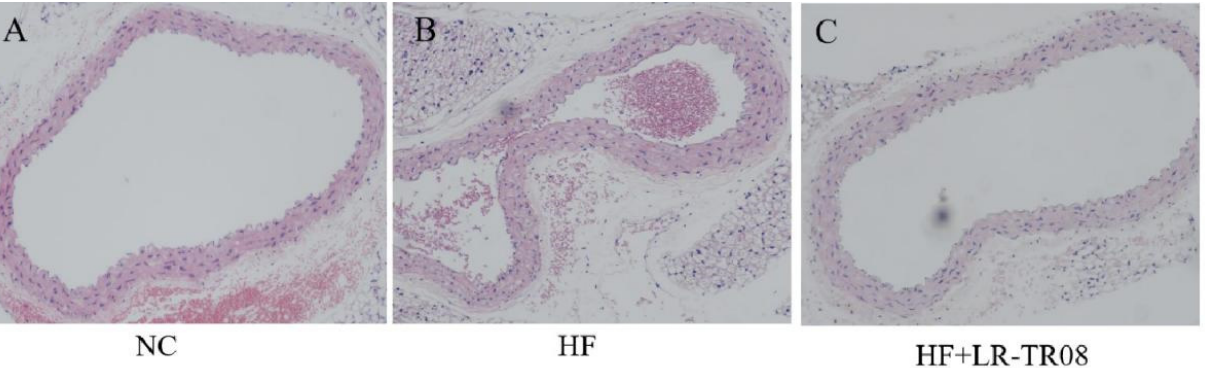
Figure 2. HE staining of mouse aortic tissue. The fixed blood vessels were embedded in wax and dehydrated for cut preparation (6 μ m thickness). Normal control group: NC, high − fat diet group: acetic acid, propionic acid, and butyric acid in the plasma of the HF+LR–TR08 group were HF, and high − fat diet + L. rhamnosus TR08 strain group: HF+LR − TR08. significantly increased in comparing with both the HF and NC groups ( p < 0.05) (Figure 3c).